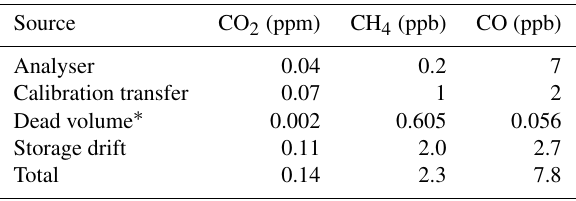
Table 3. Uncertainty based on the different error sources for CO 2 , CH 4 and CO. The total uncertainty is calculated using Gaussian error